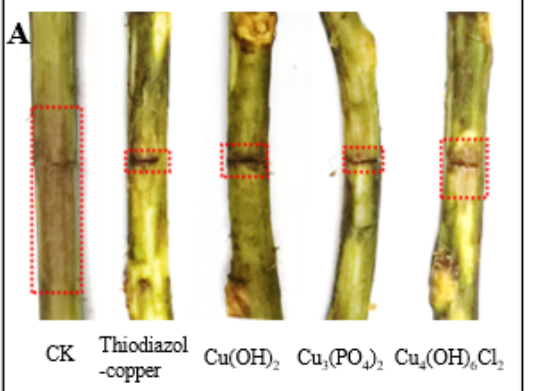
Figure 4. Control e ffi cacies of copper − based nanomaterials and thiodiazole copper towards ki- wifruit bacterial canker under controllable greenhouse conditions at 200 μ g/mL. Protective activities ( A , C ); therapeutic activity ( B , D ). A one − way ANOVA with an LSD multiple comparison test was used to determine significance across all the treatments. Values in each panel followed by different letters are significantly different at p < 0.05. Figure 5 shows that the three kinds of nanoparticles can be uniformly dispersed on the leaf surface of kiwifruit in the form of nanoparticles, while the commercial bulk parti- cles with nonuniform particle sizes were unevenly distributed on the leaf surface (Figure S3).